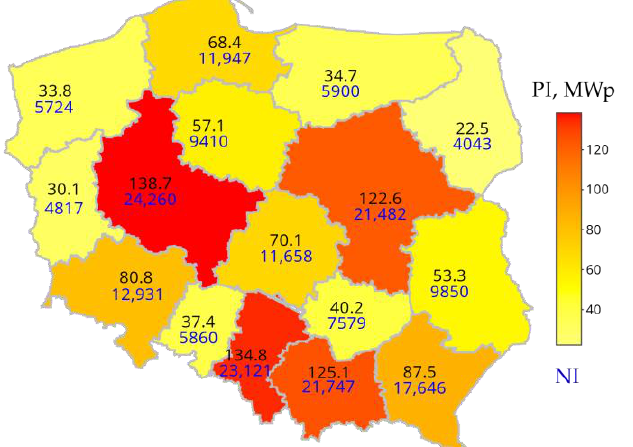
Figure 4. Results of the 2nd round of “My Electricity” recruitment carried out in 2020: number of installations (NI), power of installations (PI).